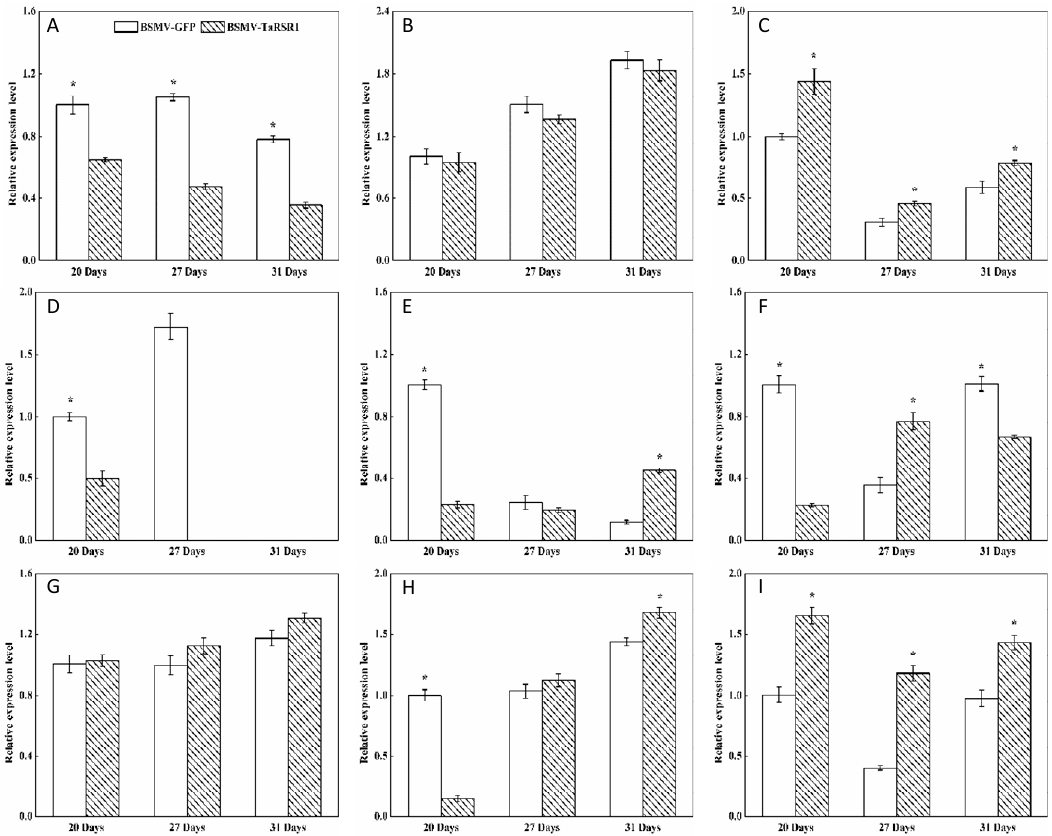
Figure 4. Transcription levels of the GBSS and SS starch synthesis-related enzyme genes in wheat grains of BSMV-TaRSR1-infected and BSMV-GFP-infected spikes at 20, 27 and 31 days after anthesis. Transcription levels were measured by qPCR using Actin gene as internal control. ( A – I ), transcription levels of TaGBSSI , TaGBSSII , TaSSI , TaSSIIa , TaSSIIb , TaSSIIc , TaSSIIIa , TaSSIIIb and TaSSIV genes, respectively. Each value is the mean ± standard deviation of three independent biological replicates. Asterisks indicate significant differences ( p < 0.05).